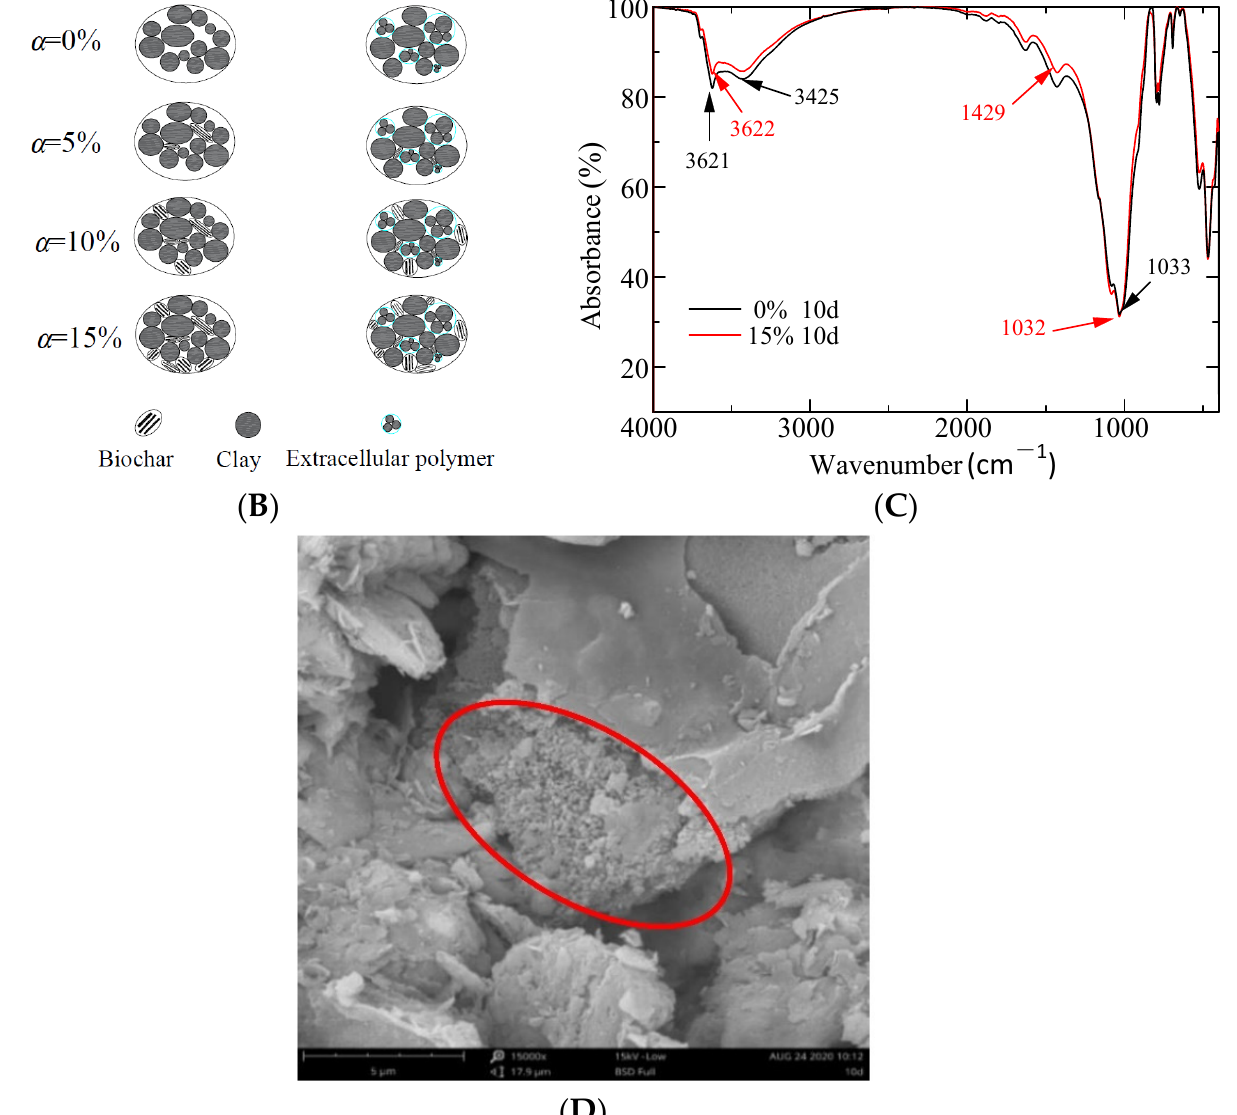
Figure 8. Microstructure and schematic diagram of biochar–clay mixed with bacteria. ( A ) SEM images of biochar–clay mixed soils with various biochar content: ( a ) α = 0%; ( b ) α = 5%; ( c ) α = 10%; ( d ) α = 15%. ( B ) Schematic diagram of the microstructure evolution of the biochar–clay mixed with bacteria. ( C ) Fourier transform infrared spectroscopy analysis of biochar–clay mixed soil. ( D ) Fou- rier transform infrared spectroscopy analysis of biochar–clay mixed soil.